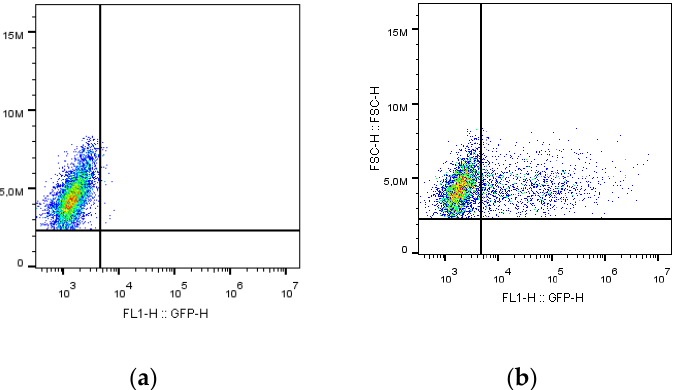
Figure 3. Green fl uorescence analysed by FC of HEK 293-ACE2 cells under two conditions: Figure 3. Green fluorescence analysed by FC of HEK 293-ACE2 cells under two conditions: nontrans- nontransduced ( a ) and transduced ( b ) with SARS-CoV-2 lentivirus. duced ( a ) and transduced ( b ) with SARS-CoV-2 lentivirus. which a titre of around ~6.69 × 10 6 TU/mL was obtained. The values showing the most linearity along the twofold dilution curve were chosen to calculate the titre. SARS-CoV-2 lentivirus preparation had a titre around ~3 × 10 5 TU/mL (average measured on fi ve independent experiments of viral preparation), and this titre was about one order of magnitude lower [27] than those achieved with VSV lentivirus, in which a titre of around ~6.69 × 10 6 TU/mL was obtained.